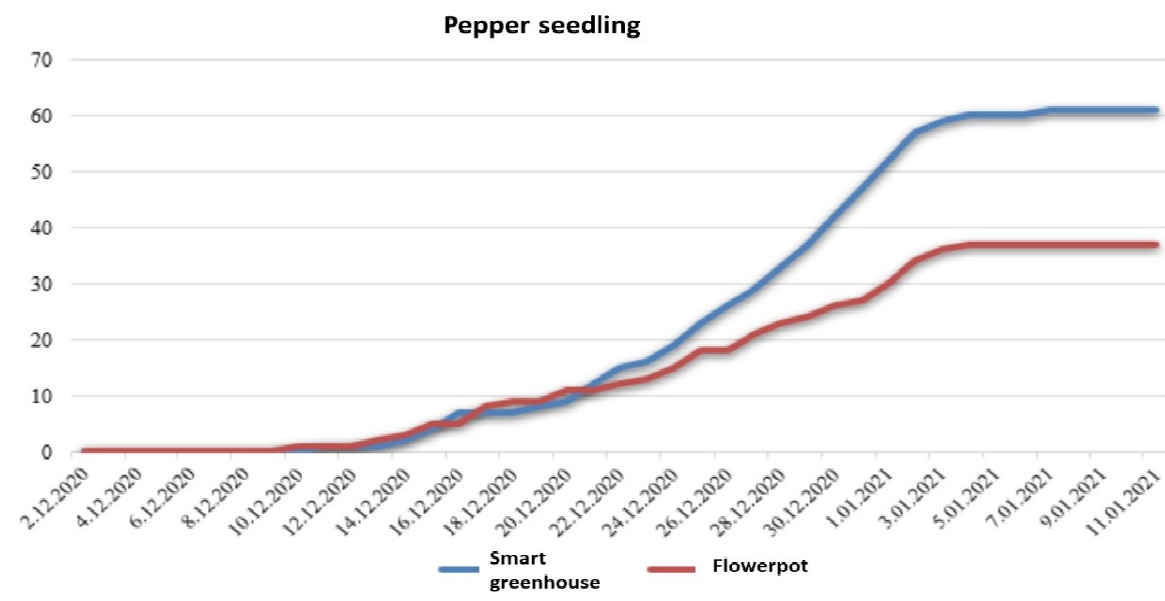
Figure 16. Development graph of pepper seedling in smart greenhouse and pot.